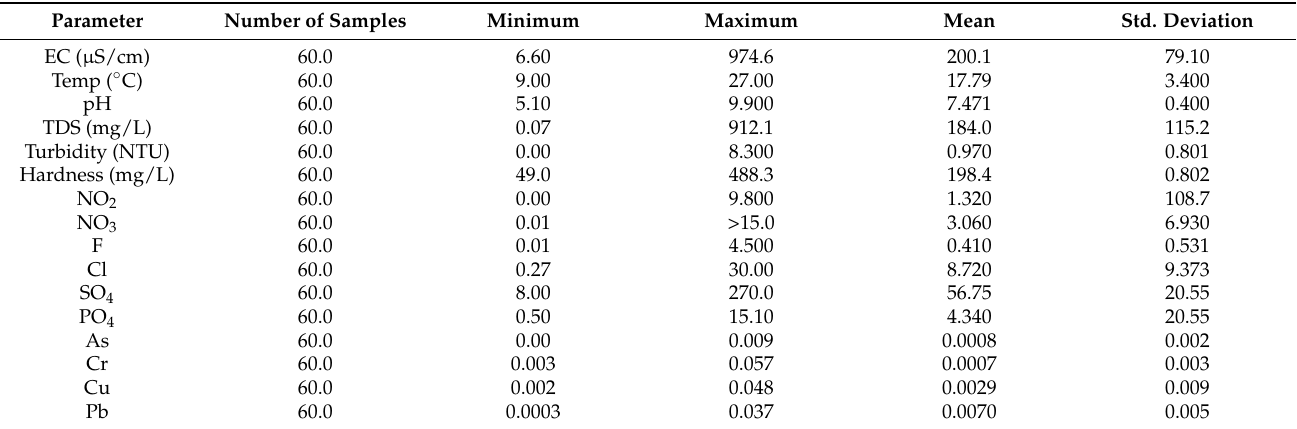
Table 1. The mean concentrations of the selected physicochemical, anionic and heavy metal parame- ters in the drinking water samples collected from the district of Neelam,